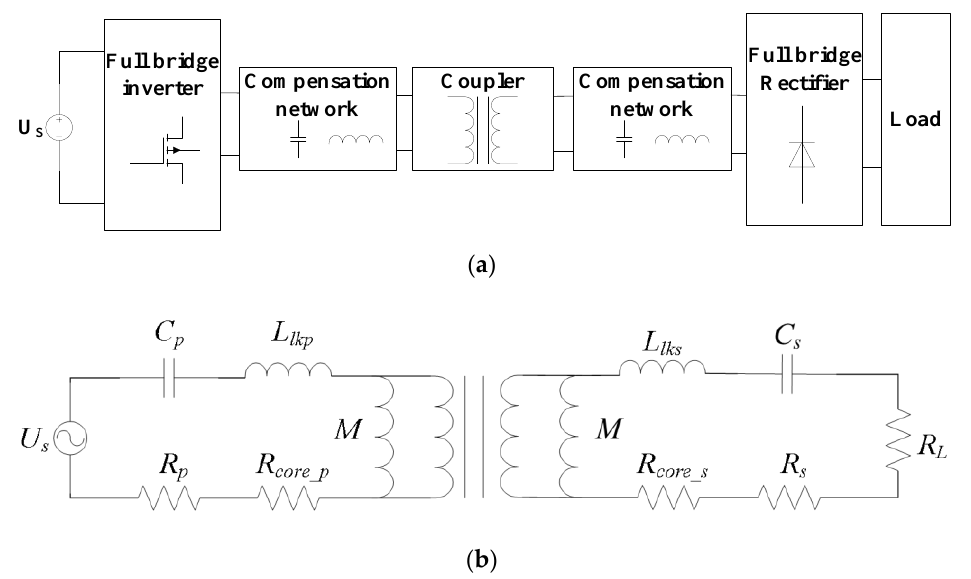
Figure 1. Typical wireless charging system considering core loss: ( a ) Sketch of the system; ( b ) Equivalent circuit. After dividing the circuit by following the Kirchhoff Voltage Law (KVL), the matrix can be derived as follows,